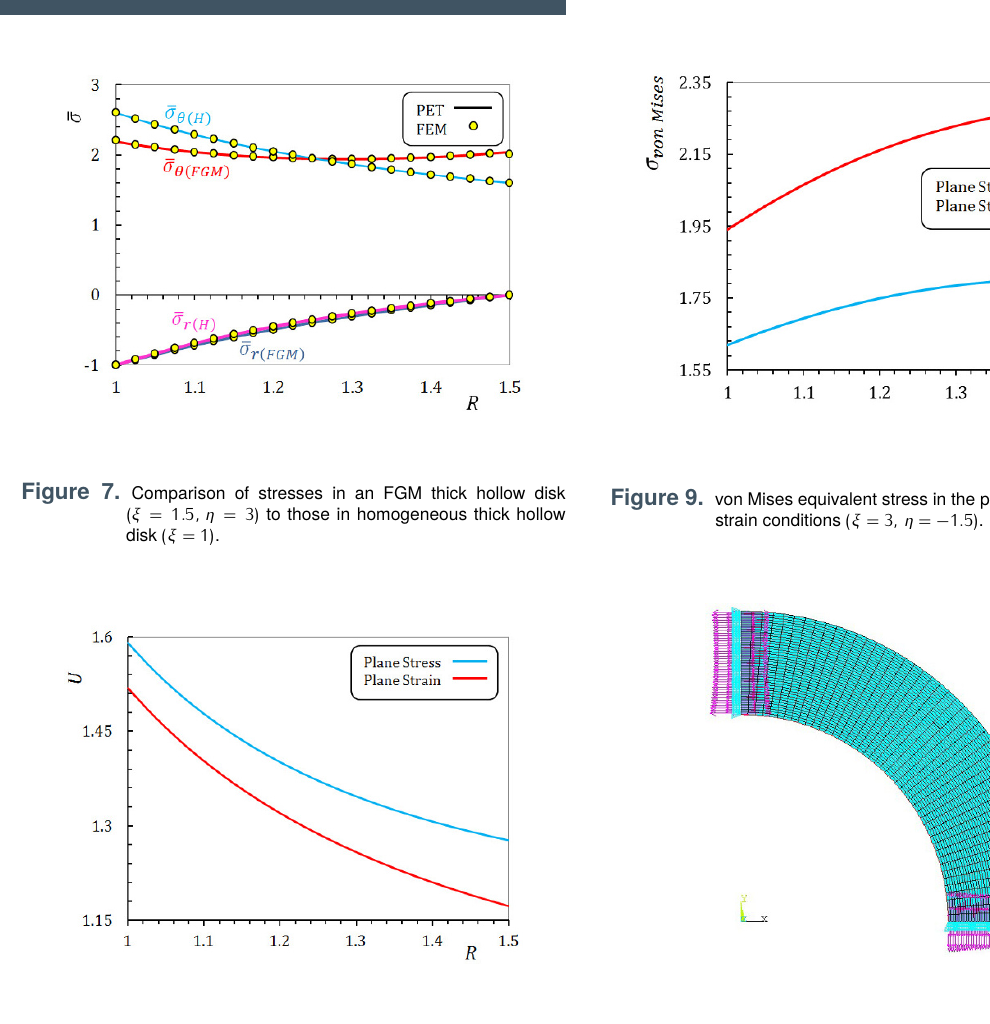
Figure 8. Radial displacement in the plane stress and plane strain conditions ( ξ = 3 , η = − 1 . 5) .